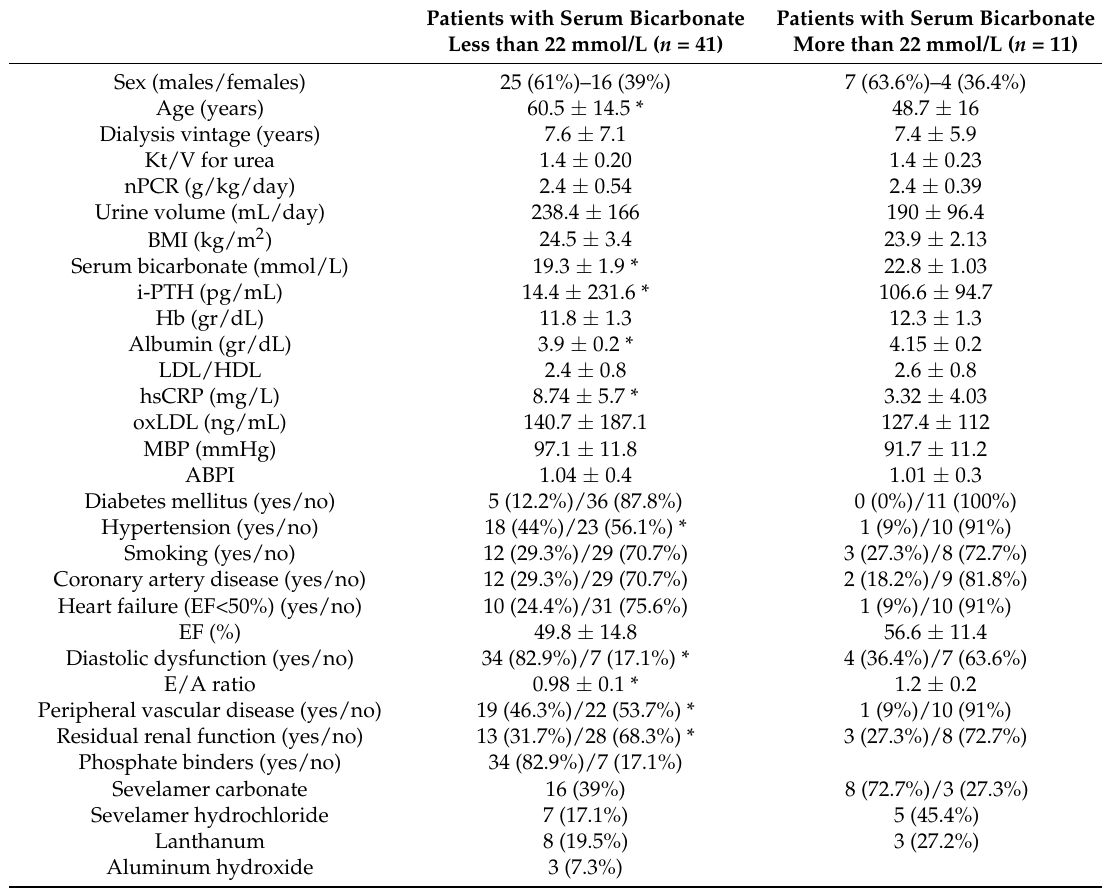
Table 1. Differences between groups of patients according to lower or higher than 22 mmol/L serum bicarbonate levels in a total of 52 patients enrolled in the study. i-PTH, intact-parathormone; MBP, Mean peripheral pre-dialysis BP; ABPI, ankle-brachial blood pressure index; EF, ejection fraction; E/A, ratio of early-to-late transmitral flow